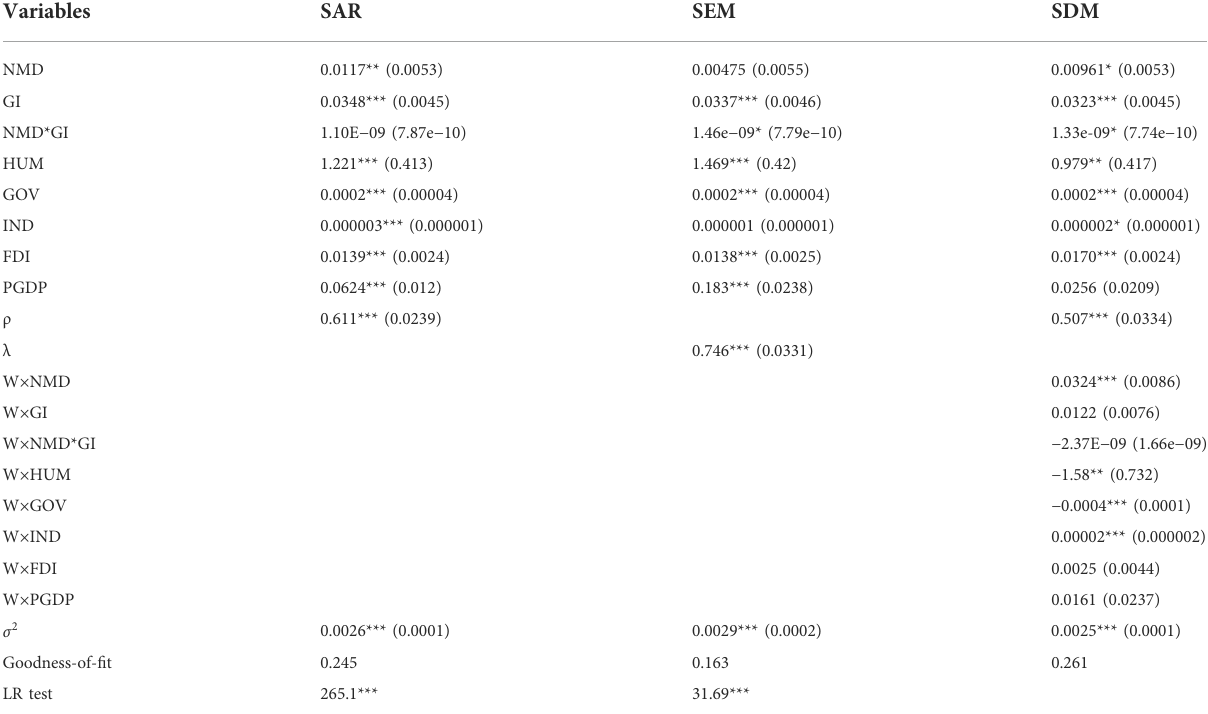
TABLE 4 Model regression